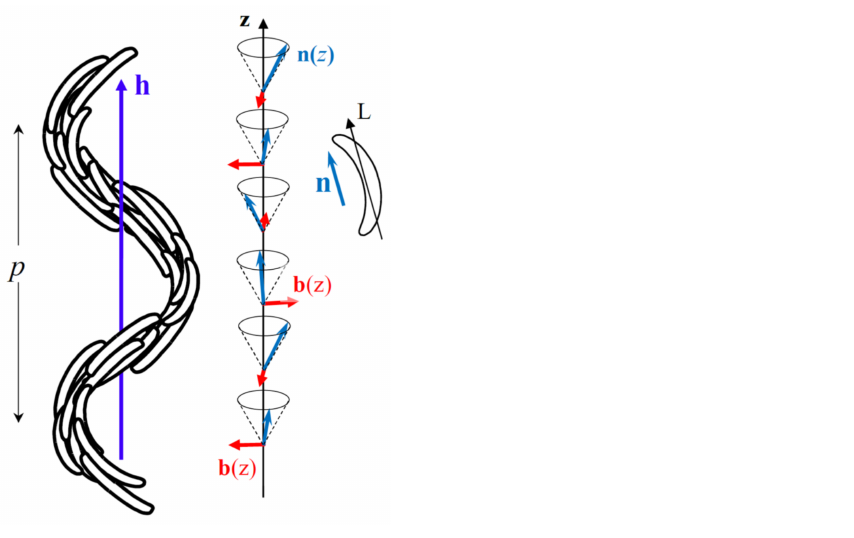
Figure 1. Heliconical structure of the N TB phase. The long axes, L , of the bent-shaped molecules are on average oriented parallel to the nematic director, n . Along the helix axis, h , the director rotates and follows a conical helix with pitch p . The bend vector, b , is organized on a right-angle helix. (The heliconical structure is doubly degenerate but only the right-handedness is shown here for